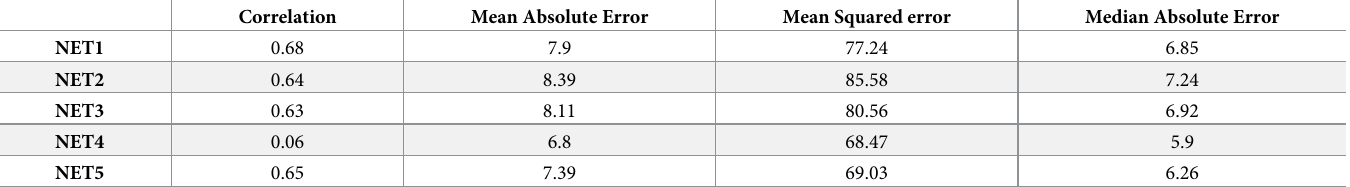
NET1 and NET5 were used to screen 31401 compounds using their SMILES (Simplified Molecular Input Line Entry System) and 3CL protease protein sequences. These compounds are derived from microbial cultures curated from the scientific literature and deposited at Pub- chem. The Rdkit package provides a module called QED63 that stands for quantitative estima- tion of the drug-likeness. The QED score is based on molecular weight, logP, topological polar surface area, the number of hydrogen bond donors and acceptors, the number of aromatic Table 2. Performance of the Binding DB pIC 50 pre-trained models on the known set of antiviral compounds for ssRNA viruses.